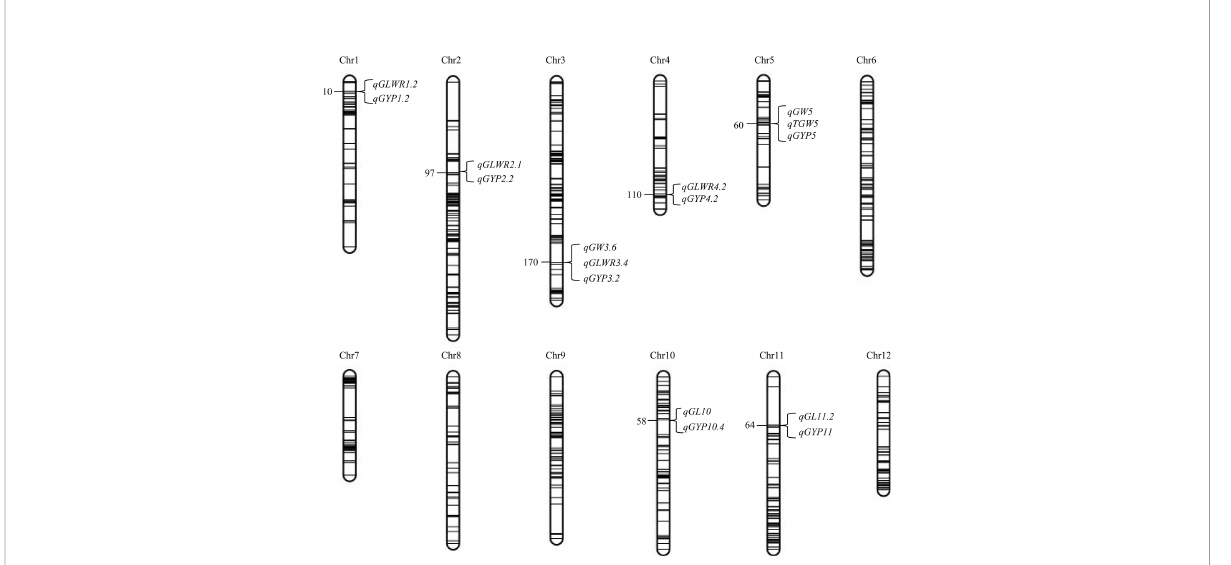
FIGURE 3 mQTL affecting grain shape and grain weight as well as grain yield traits detected in BC 1 F 1 s and the corresponding H MP s in Hefei (HF) and Nanning (NN). Number on the left side of the chromosome indicates the genetic position of the QTL in cM. The linkage map spans 2,268 cM with a mean of 2.65 cM between neighboring